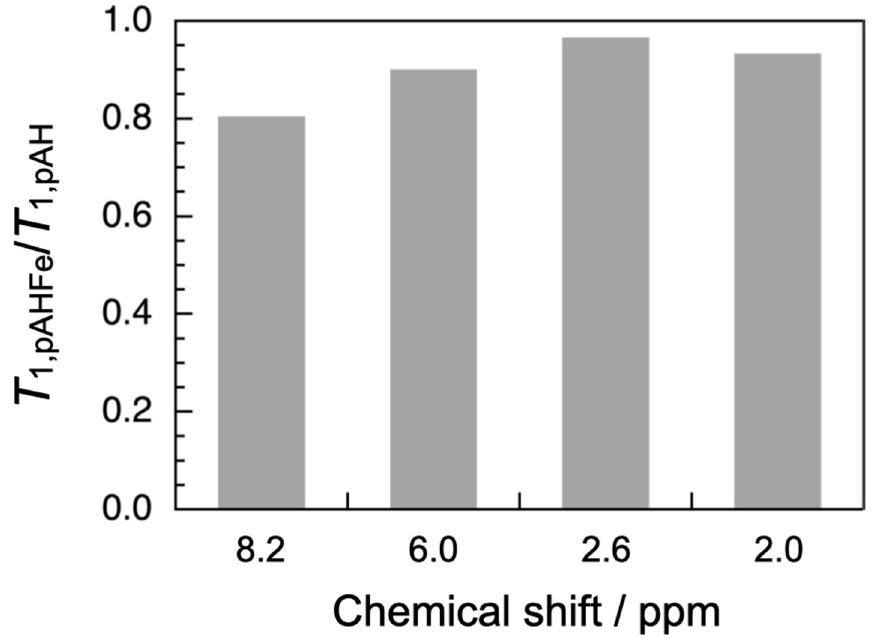
Figure 7. T 1,pAHFe / T 1,pAH for 1 H NMR